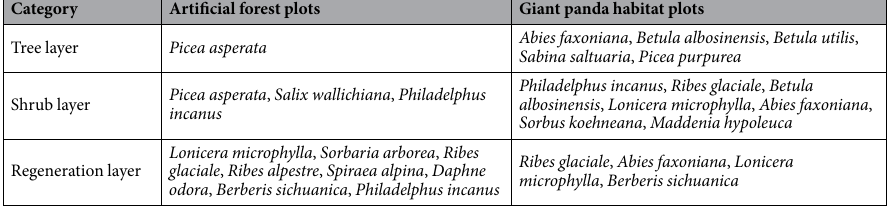
Table 1. Dominant species of different layers in artificial forest plots and giant panda habitat